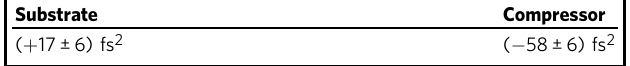
Table 3 Femtosecond pulse compression: optics GDD in the full working range (760 – 840